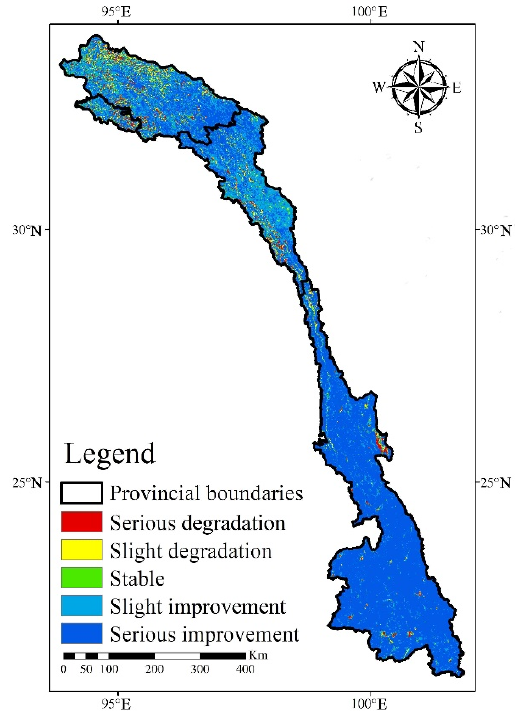
Figure 2. Change trend of NDVI in the Lancang River Basin from 1998 to 2020.